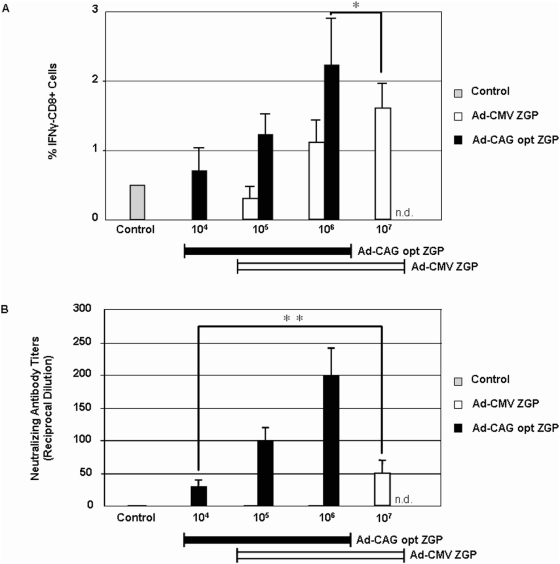
T and B cell responses following immunization.B10.BR mice were vaccinated I.M. with Ad-CMVZGP (1×105, 1×106 and 1×107 IFU/mouse) or Ad-CAGoptZGP (1×104, 1×105 and 1×106 IFU/mouse) and splenocytes were harvested 8 days later for A. IFN-γ CD8+ T cells frequency analysis or B. Neutralizing antibody (NAB) titers. Four to five mice were analyzed per group and the experiment was repeated twice. Levels of NAB to ZEBOV-EGFP were evaluated 25 days post-vaccination. Error bars represent the standard deviation of the data. n.d. refers to assays that were not done for Ad-CAGoptZGP at that IFU/mouse. * p = 0.0454; ** p = 0.1.